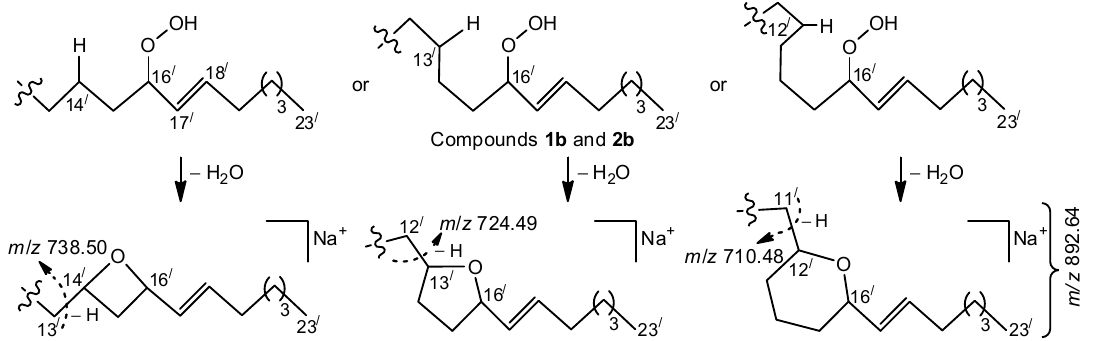
Scheme 2. Possible formation of the homologous ions of m / z 738.50, 724.49, and 710.48.